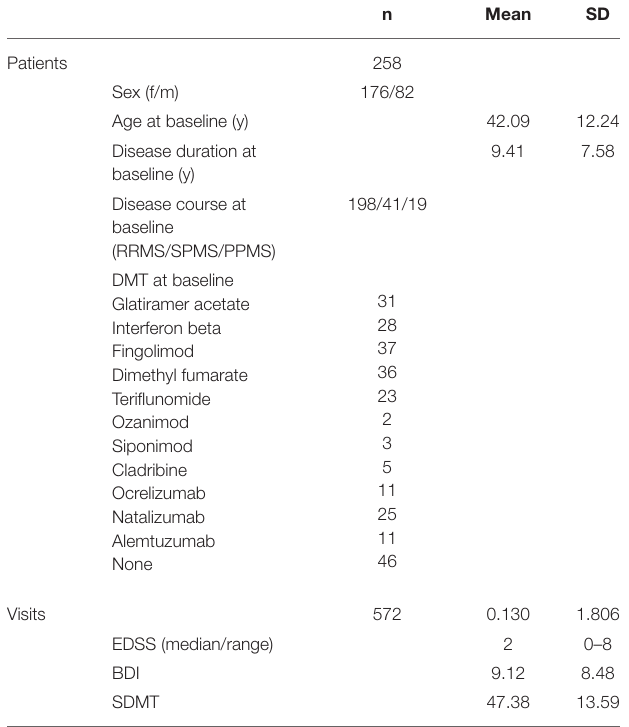
TABLE 1 | Patients’